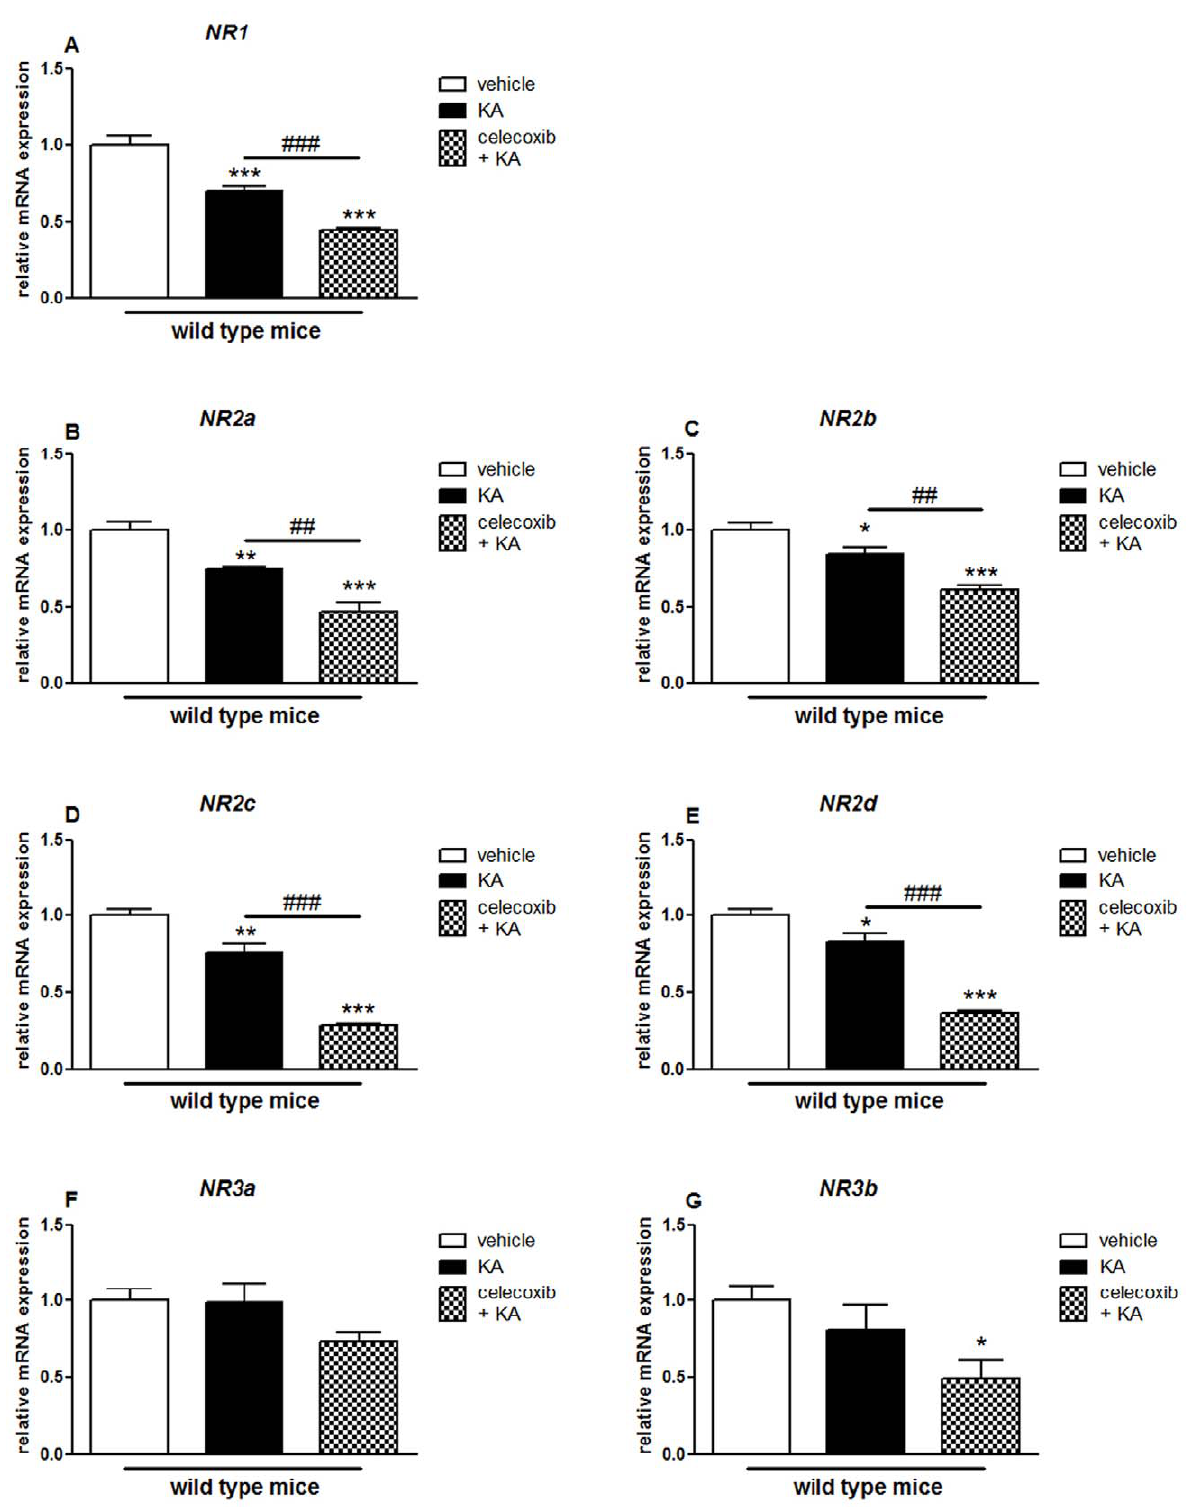
Figure 8. Effects of pretreatment with celecoxib on KA-induced mRNA expression of NMDA receptor subunits in the hippocampus of wild type mice. Quantitative real time-PCR analysis of NR1 (A), NR2a (B), NR2b (C), NR2c (D), NR2d (E) NR3a (F), NR3b (G) in WT mice, after two weeks treatment with celecoxib, followed by an i.p. injection of KA or vehicle 24 hours later. Data are means 6 SEM ( n =9). Statistical analysis was performed using a one-way ANOVA and Bonferroni’s post-hoc test. *P , 0.05, **P , 0.01, *** P , 0.001 compared to vehicle-injected WT mice; # P , 0.05, ## P , 0.01, ### P , 0.001 compared to KA-injected WT mice.